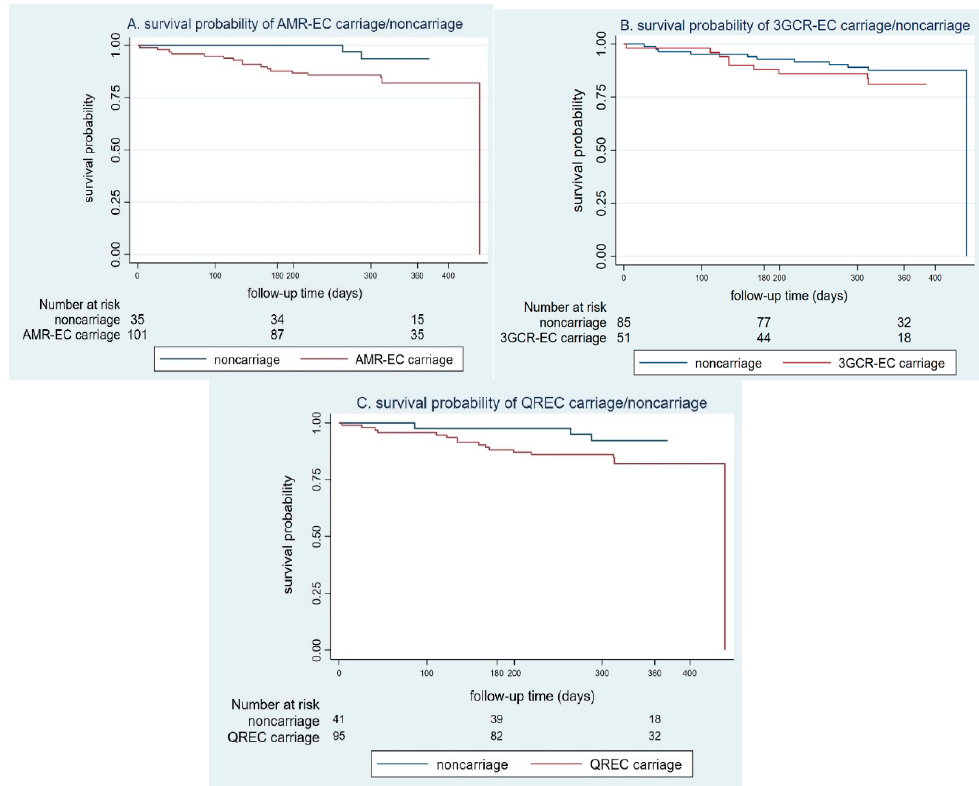
Figure 1. The survival probability between carriage (red line) and noncarriage (blue line) antimicro- bial-resistant Enterobacterales stratified by types of resistance: ( A ) AMR-EC ( p value log-rank 0.10); ( B ) 3GCR-EC ( p value log-rank 0.32); ( C ) QREC ( p value log-rank